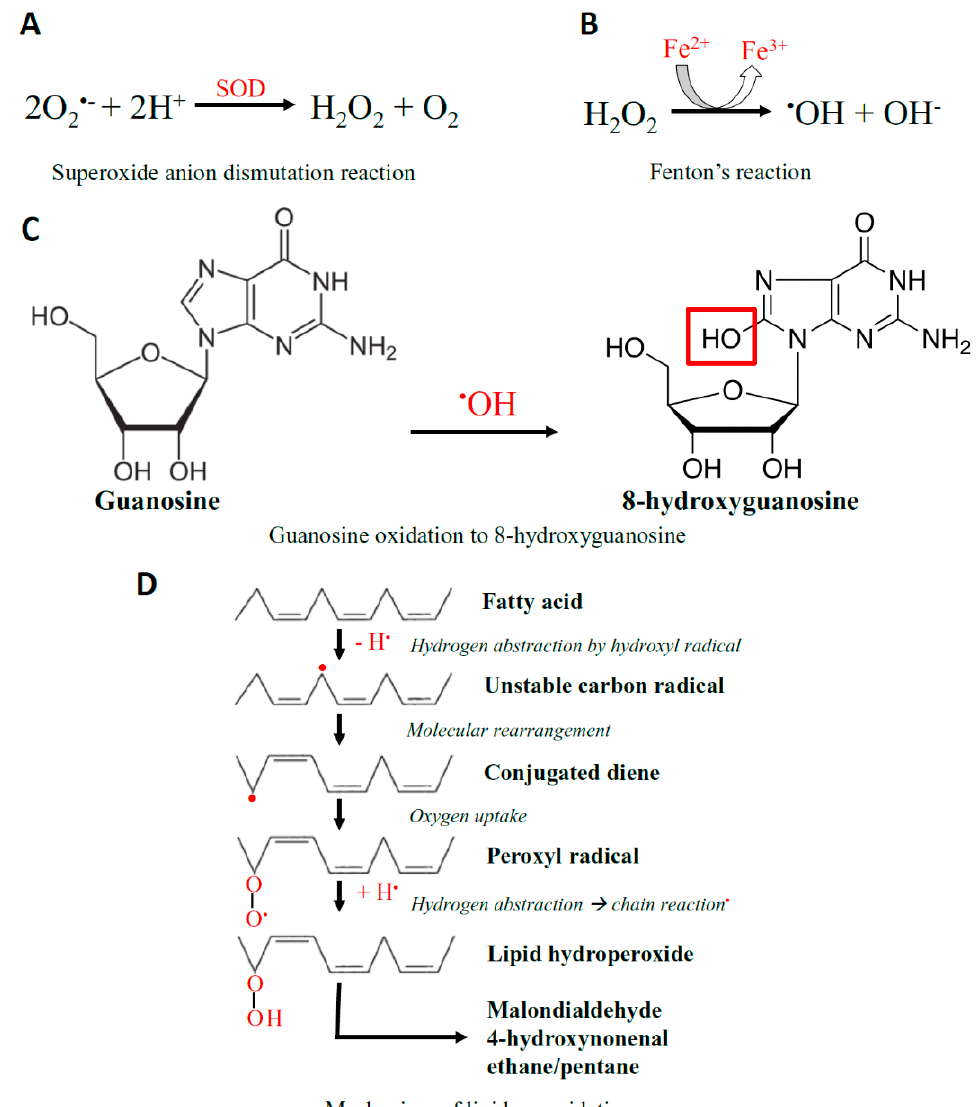
Figure 2. The Chemistry of ROS. ( A ) Superoxide anion (O 2 •− ) undergoes a dismutation reaction in the presence of the superoxide dismutase (SOD) enzyme, converting it into hydrogen peroxide (H 2 O 2 ) and oxygen. ( B ) H 2 O 2 is then converted to secondary ROS, being hydroxyl radical ( • OH) by Fenton’s reaction. ( C ) Hydroxyl radicals are capable of promoting the oxidation of guanosine to 8-hydroxyguanosine. ( D ) The hydroxyl radical is also able to react with polyunsaturated fatty acid residues of phospholipids, which are highly sensitive to oxidation, resulting in lipid peroxidation.